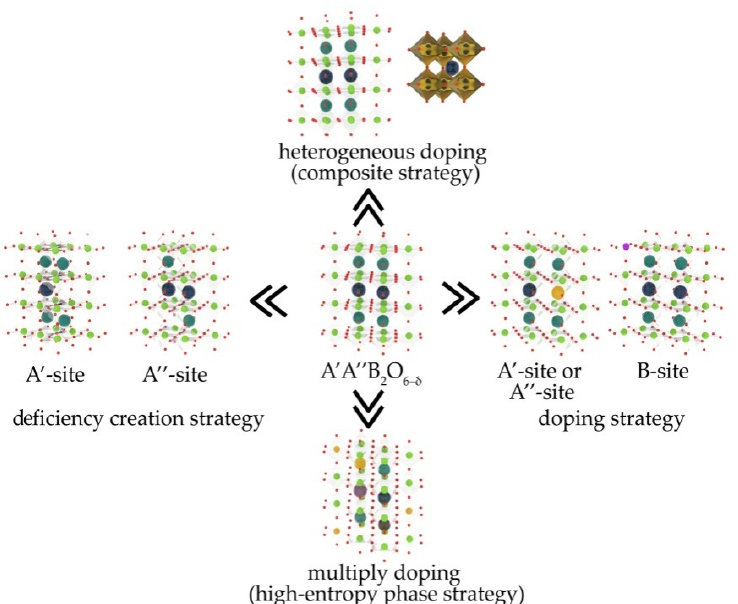
Figure 12. Different strategies of improving the performance of A’A”B 2 O 6– δ layered oxygen deficient double